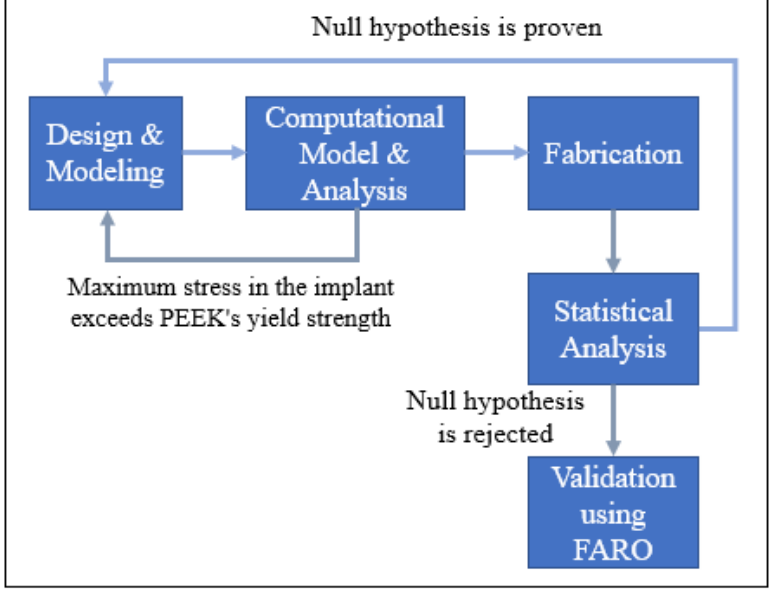
Figure 8. Scenarios for redesigning the implant.